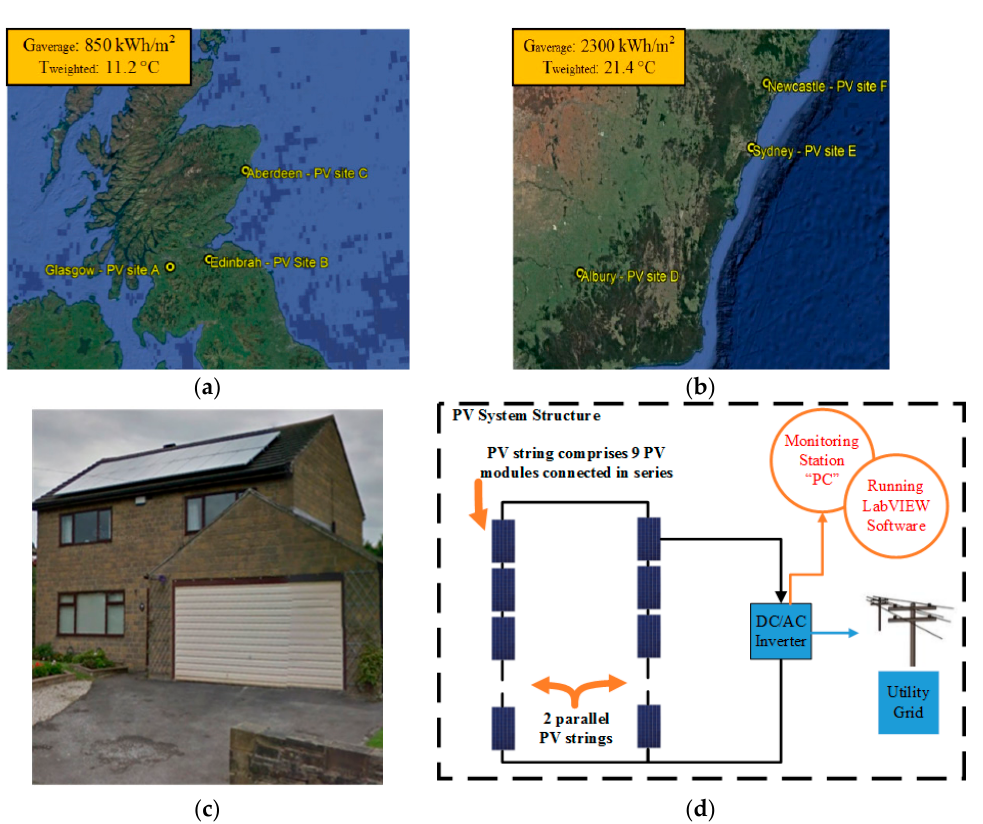
Figure 1. Examined photovoltaic (PV) systems: ( a ) geographical distribution of the examined PV systems located in the United Kingdom including the average irradiance and weighted temperature over the last 30 years; ( b ) geographical distribution of the examined PV systems located in the Australia including the average irradiance and weighted temperature over the last 30 years; ( c ) real picture of the examined PV system installed in Glasgow site—PV site A; ( d ) PV sites configurations, comprising two parallel PV strings, each consisting of nine series connected PV modules.